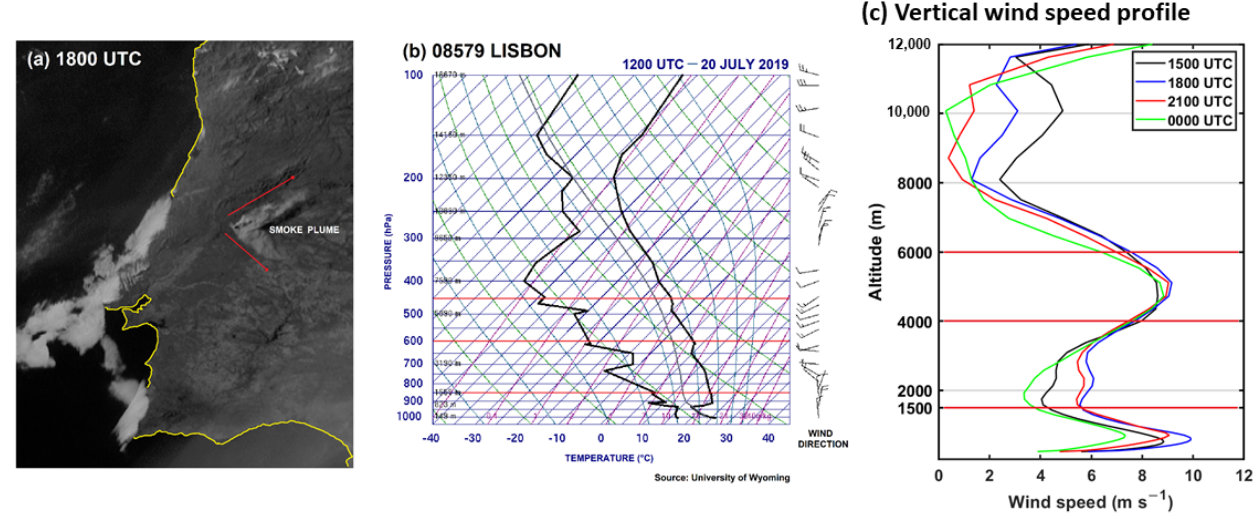
Figure 3. ( a ) Satellite images of the fire smoke plume over Vila de Rei’s wildfire in the afternoon of 20 July 2019 at 1800 UTC; (b ) Skew-T log-P diagram observation in Lisbon on 20 July 2019 at 1200 UTC; ( c ) Vertical wind speed profile at the fire’s start point during 20 and 21 July 2019.